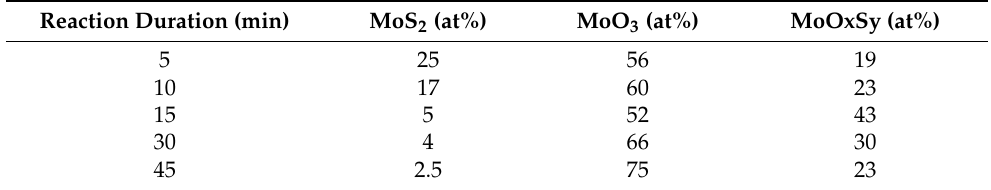
Table 5. Evolution with the reaction time of the composition of the hybrid thin film (3% H 2 O 2 , in the darkness), based on decomposition of Mo 3d